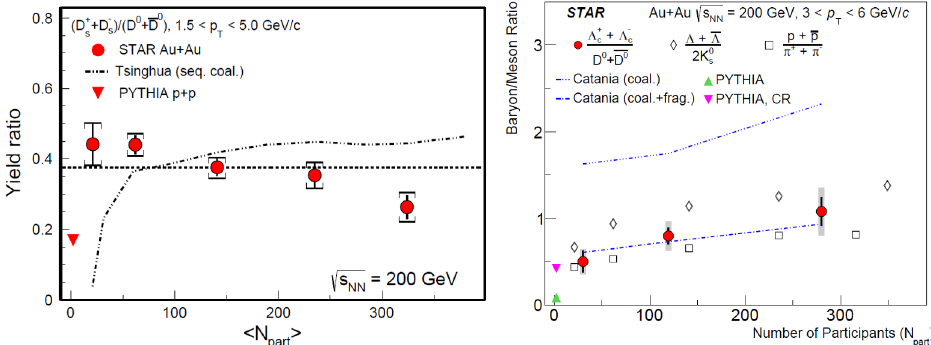
+ D − ) / ( D 0 + ¯ D 0 ) [16] vs. < N part > measured by STAR at s s + Λ − ) / ( D 0 + ¯ D 0 ) vs. < N part > c c